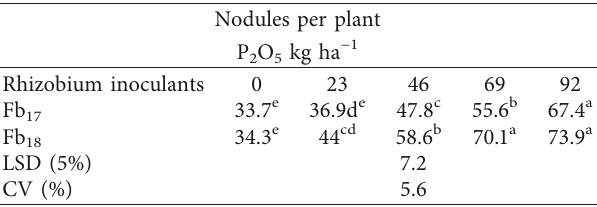
Table 9: The main effects of rhizobium inoculation and P fertilizer levels on plant